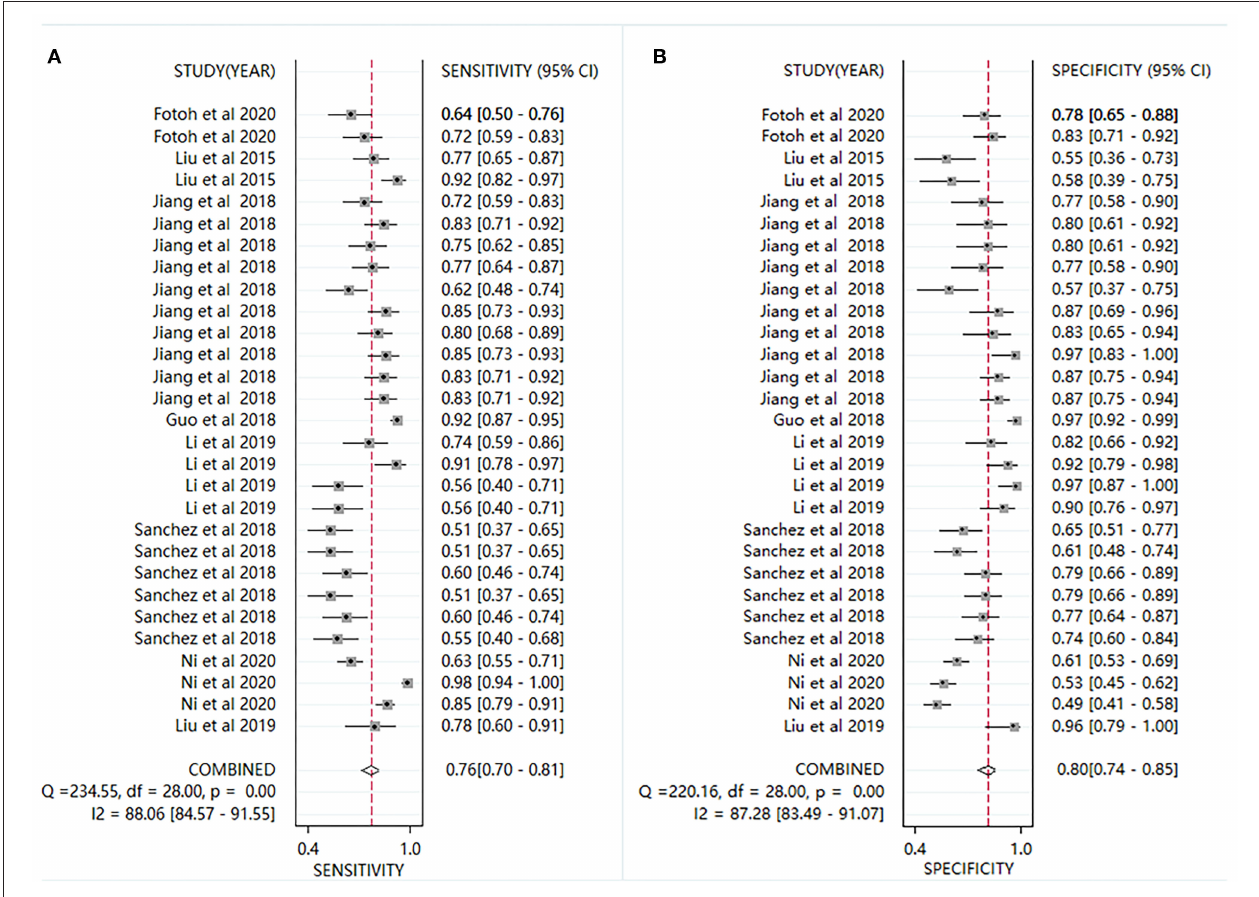
FIGURE 3 | Forest plots for studies on individual miRNA used in the diagnosis of AS among the 29 studies included in the meta-analysis. (A) sensitivity; (B)